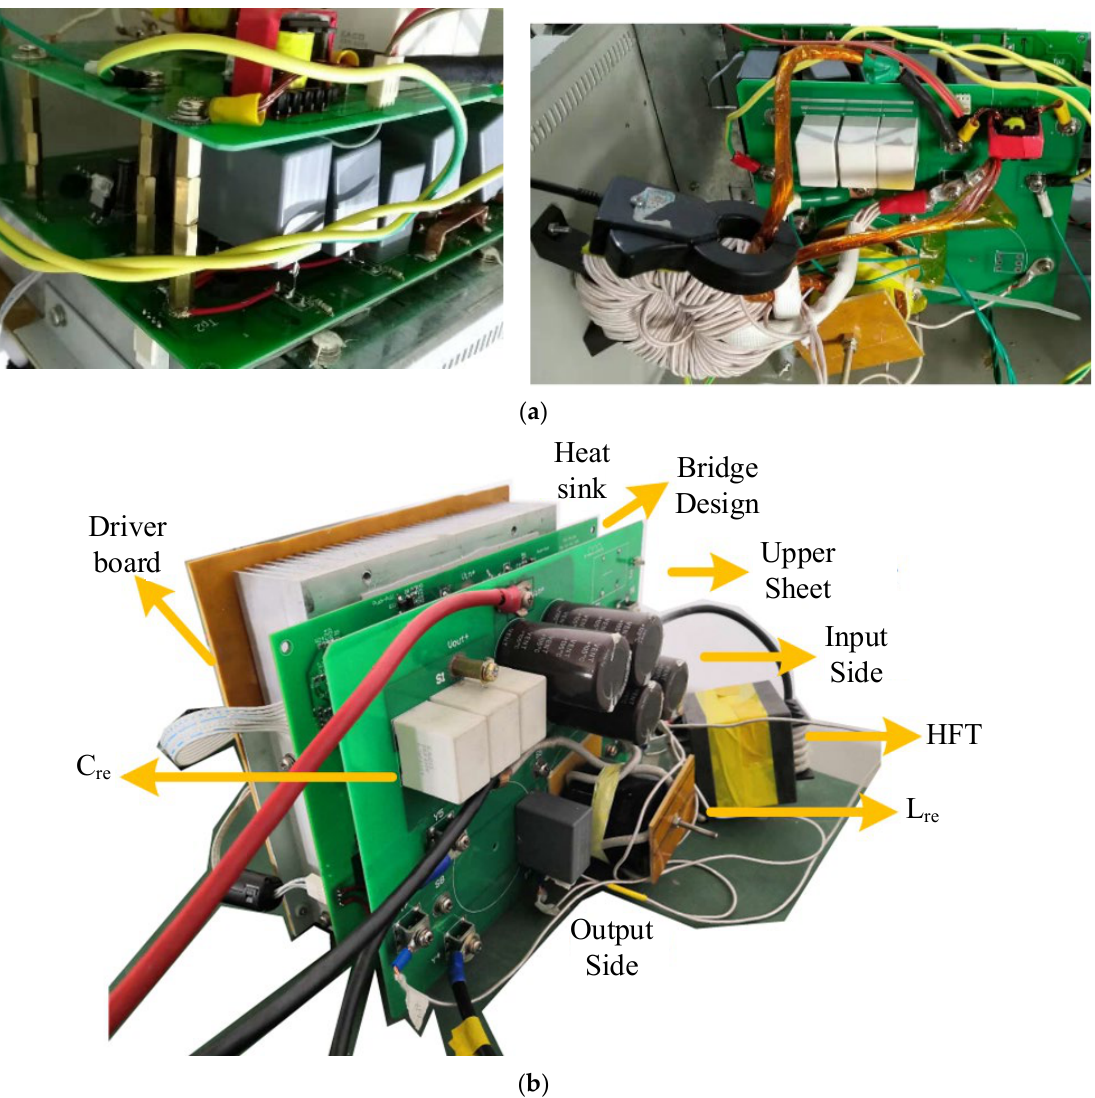
Figure 12. Experimental setup up of the proposed converter ( a ) Initial designs for the proposed converter in the lab and ( b ) Laboratory setup of proposed converter.